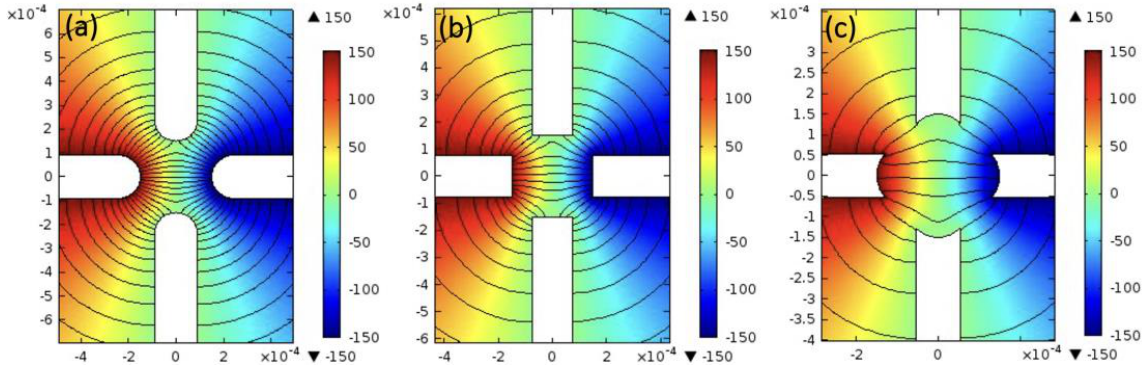
Figure 2. ( a – c ) Electric potential distribution of various electrode shapes, i.e., round electrodes, square electrodes and concaved electrodes. (length unit: m).